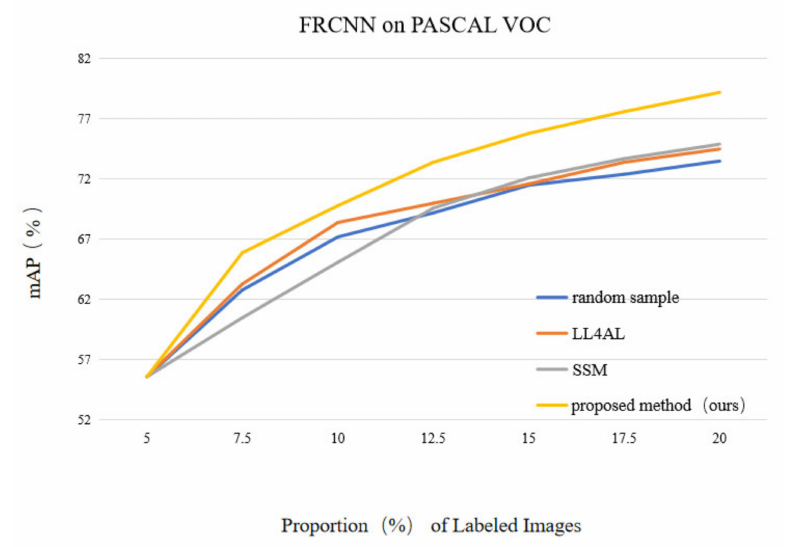
Figure 4. Performance comparison of active object detection